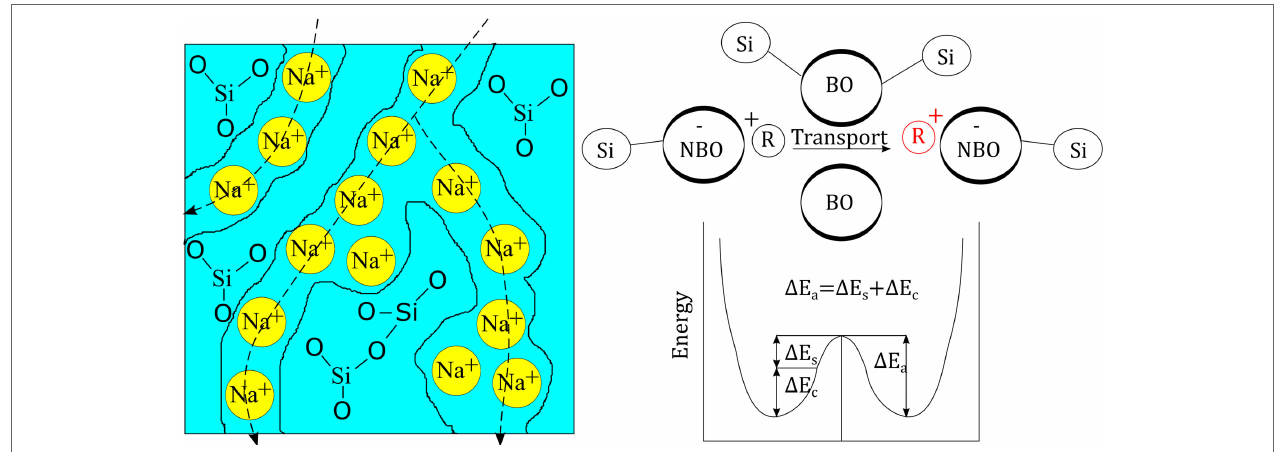
FiGUre 1 | (Left) schematic view of the glass structure of soda silicate glass as originally proposed by Greaves (1985) . (Right) Schematic view of the principle energy landscape for cationic transport (R + denoting a monovalent cation), redrawn from Martin and Angell (1986). Δ E s stands for network strain energy and Δ E c for Coulomb energy (chemical binding energy).